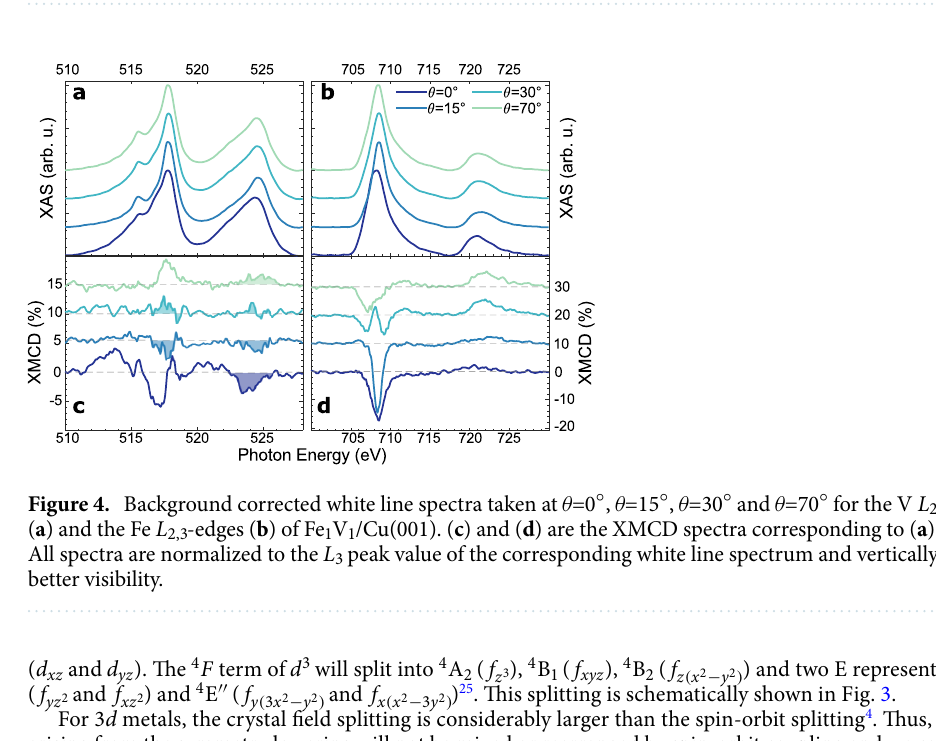
Figure 3. Sketch of the degeneracy lifting of the spherical symmetric 5 D and 4 F terms of the respective d 6 and d 3 configurations via the crystal field of a fourfold symmetric (001) surface and the form of the resulting irreducible representation. The new found representations are not ordered energetically.